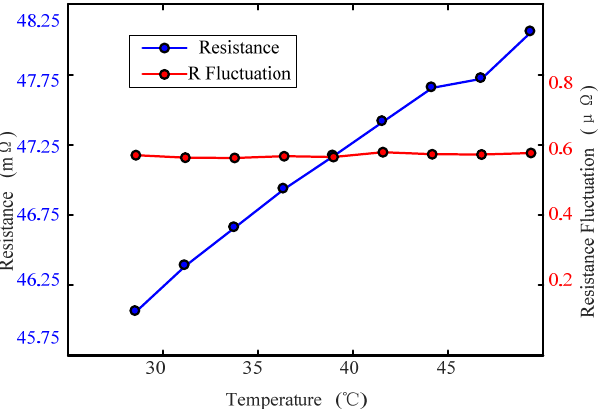
Figure 7. Static contact resistance and resistance fluctuation at 28.57 °C.